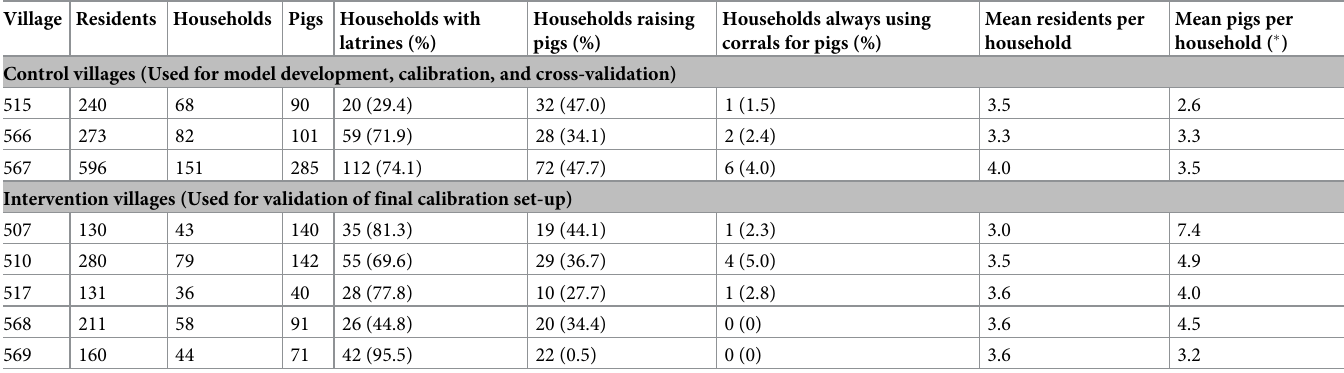
Table 1. Simulated villages characteristics. Village Residents Households Pigs Households with